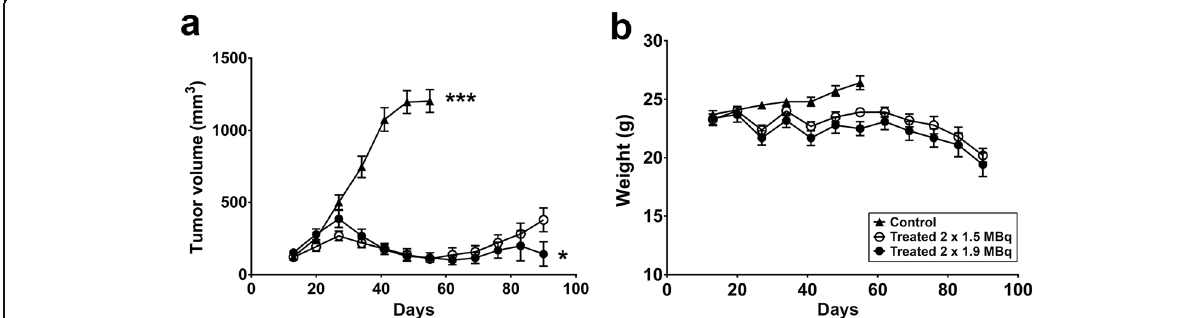
Fig. 4 Treatment of s.c. PC3-PSCA macrotumors with different activities of 211 At-A11. Tumor volumes ( a ) and mouse weights ( b ) are shown as mean ± SEM. *** p < 0.001, * p < 0.05